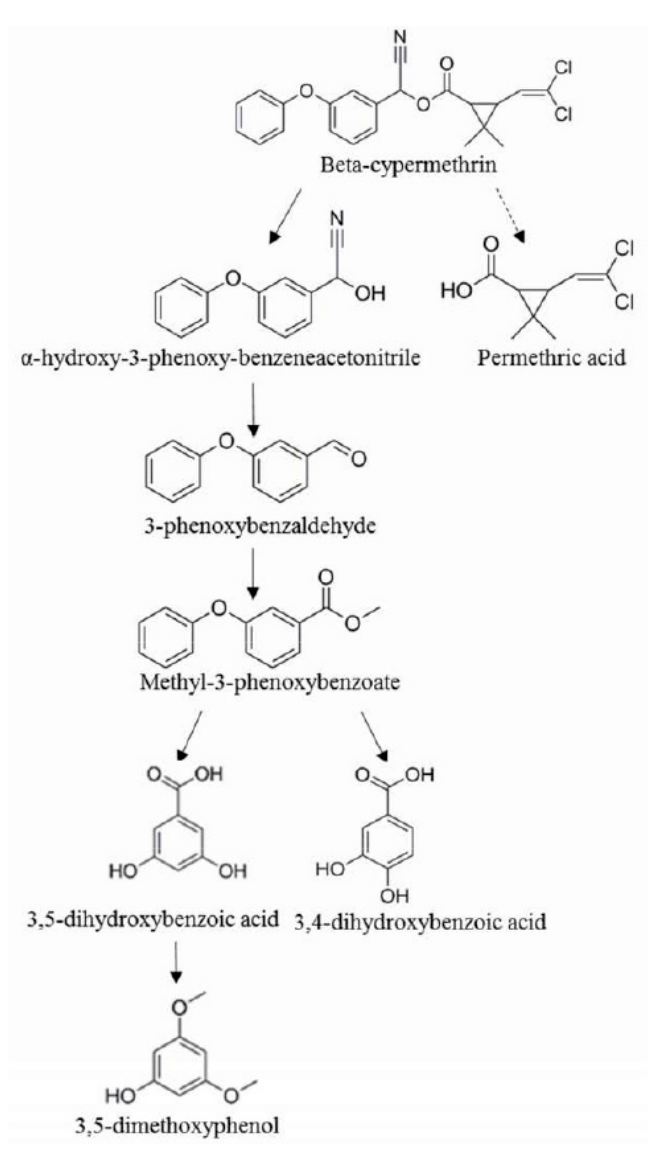
Figure 3. Proposed pathway of beta-cypermethrin through the biodegradation by strain BC001.